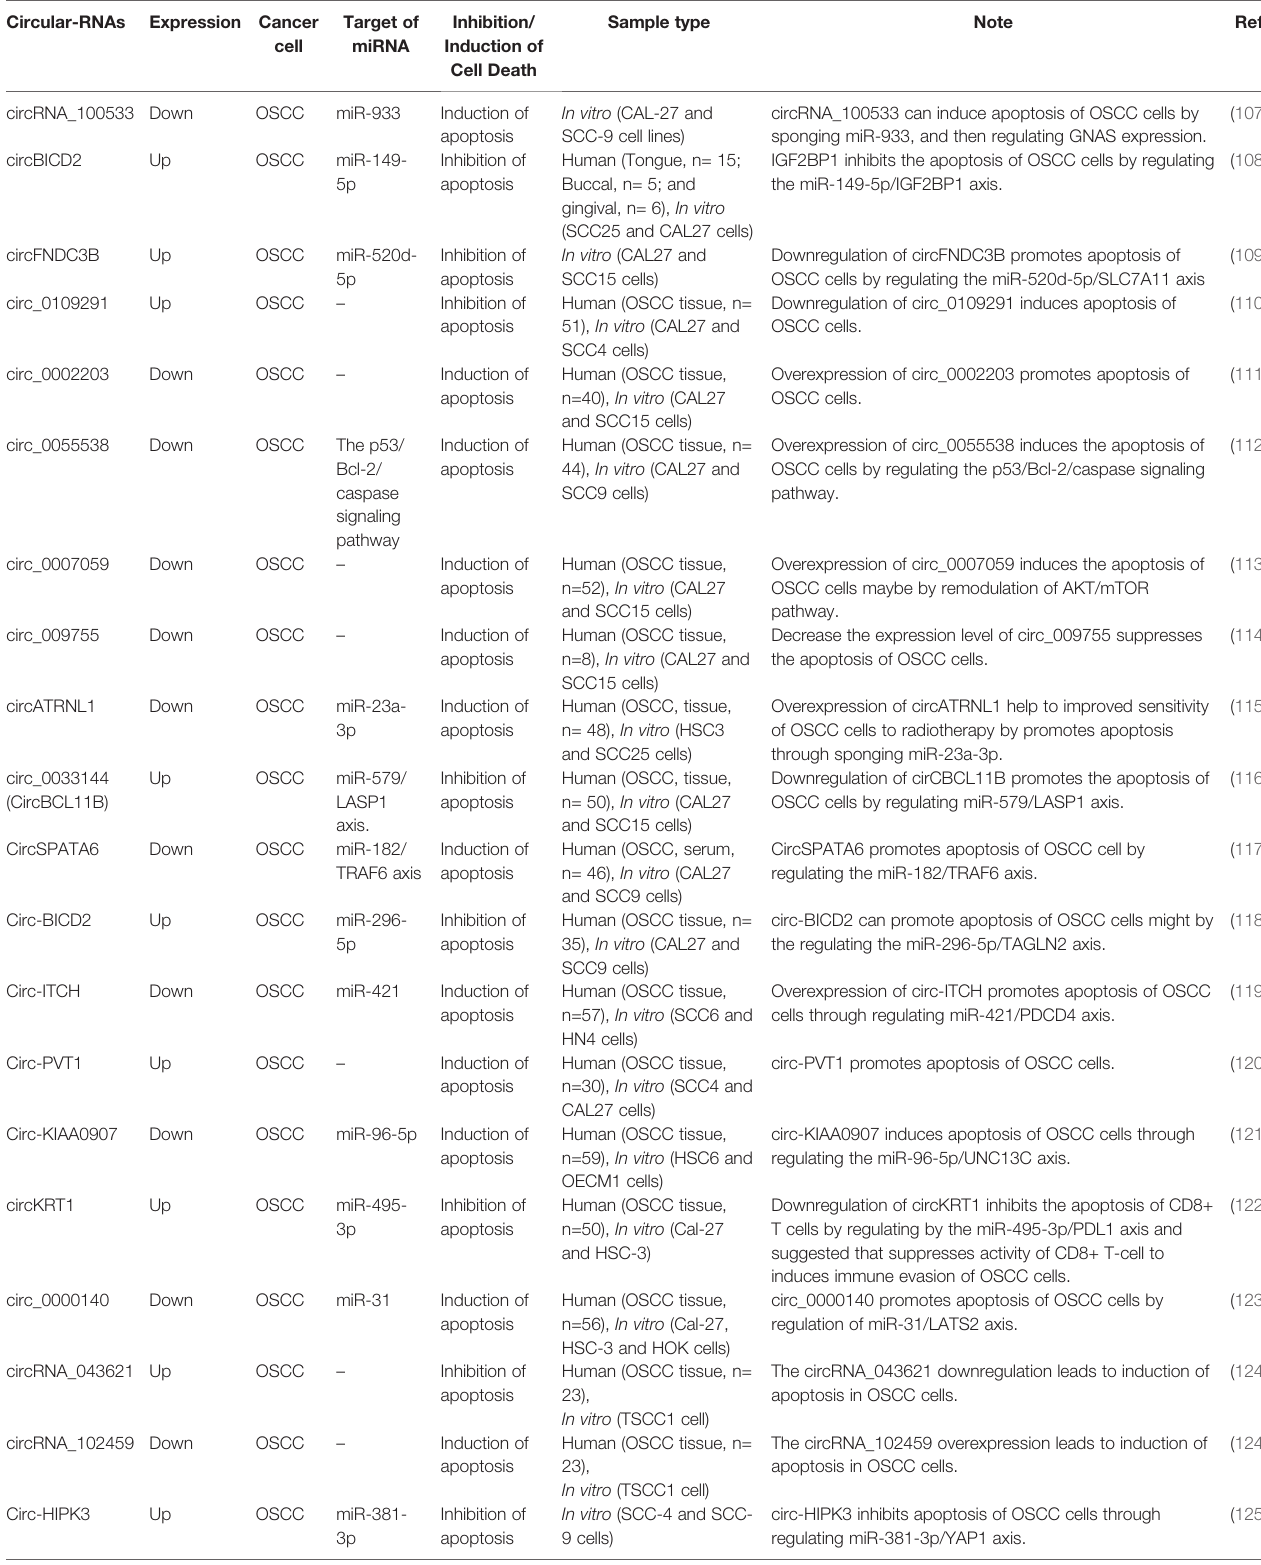
TABLE 5 | Circular RNAs can regulate cell death pathways in oral cancer. Circular-RNAs Expression Cancer